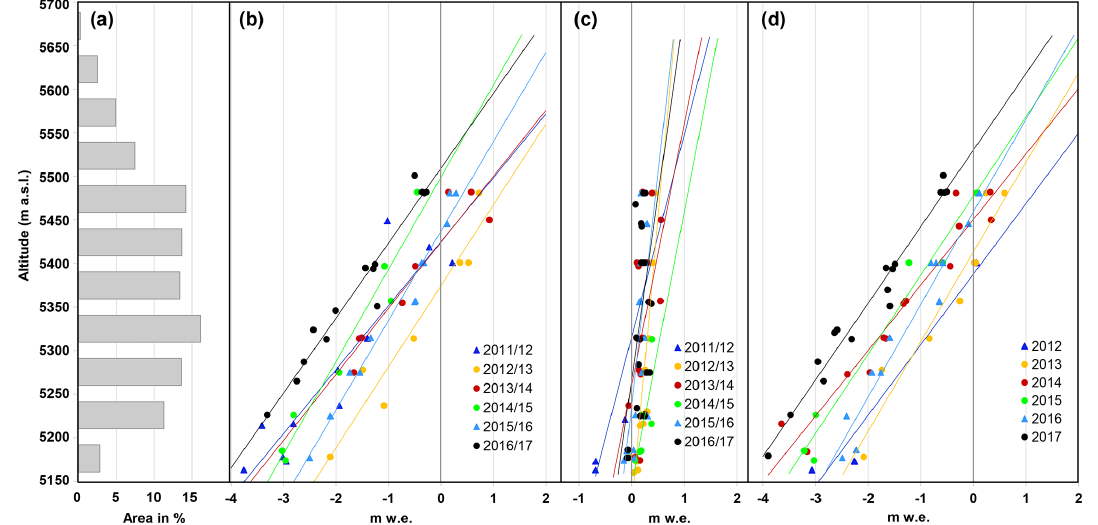
Figure 2. The glacier hypsography (a) , and the mass balances and gradients for the annual (b) , winter (c) and summer (d) mass balance for Yala Glacier from 2011–2017.